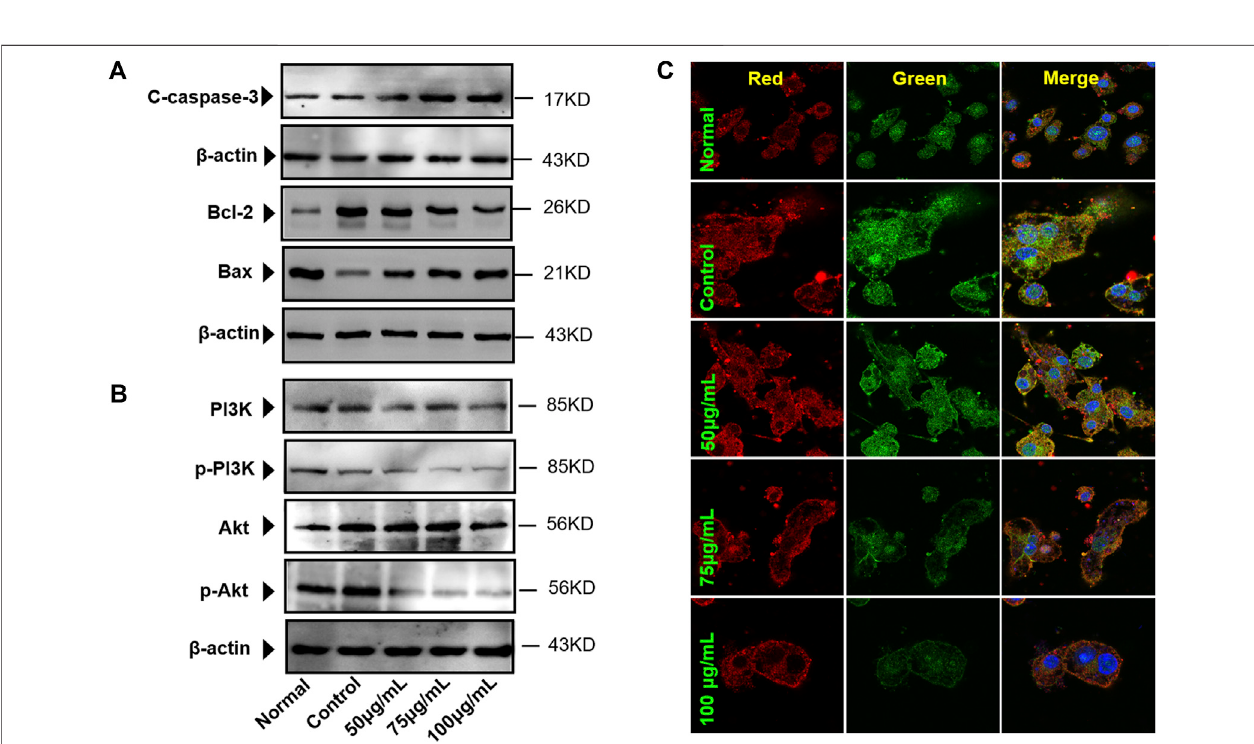
FIGURE 8 | BTP regulates apoptotic proteins in osteoclasts. (A) Caspase-3, Bcl-2, and Bax (B) Akt and PI3K in osteoclasts. (C) Akt/p-Akt expressions in cells ( × 400), p-Akt (green) and Akt (red).